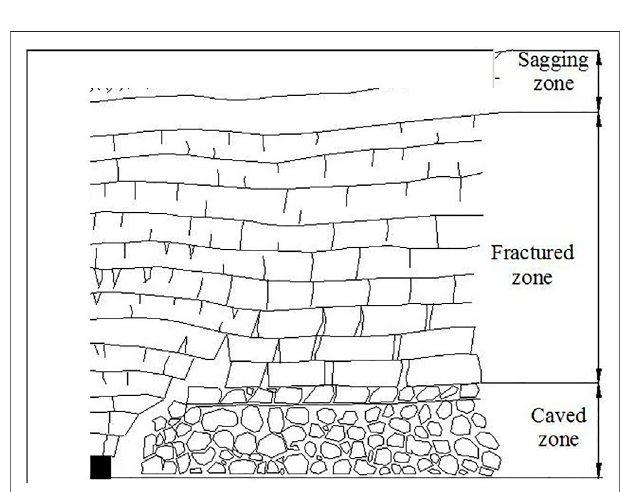
FIGURE 9 | Longitudinal distribution of three zones in the overburden in the three zone mode.